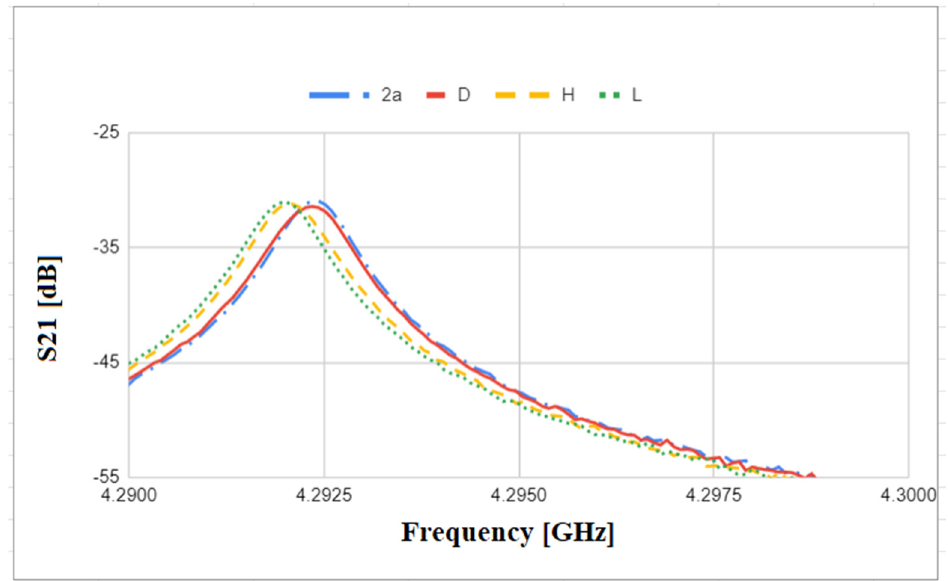
Figure 20. Location of the peaks of the master diamonds at 4.29 GHz.